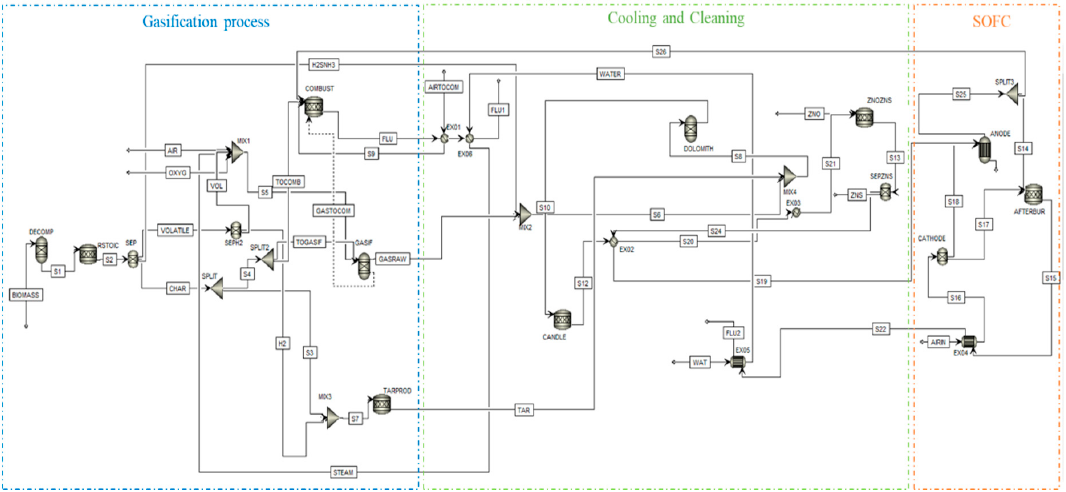
Figure 2. Flowsheet of the simulation under investigation (the hatched streams are heat streams, representing thermal recovery; the continuous streams are material streams).